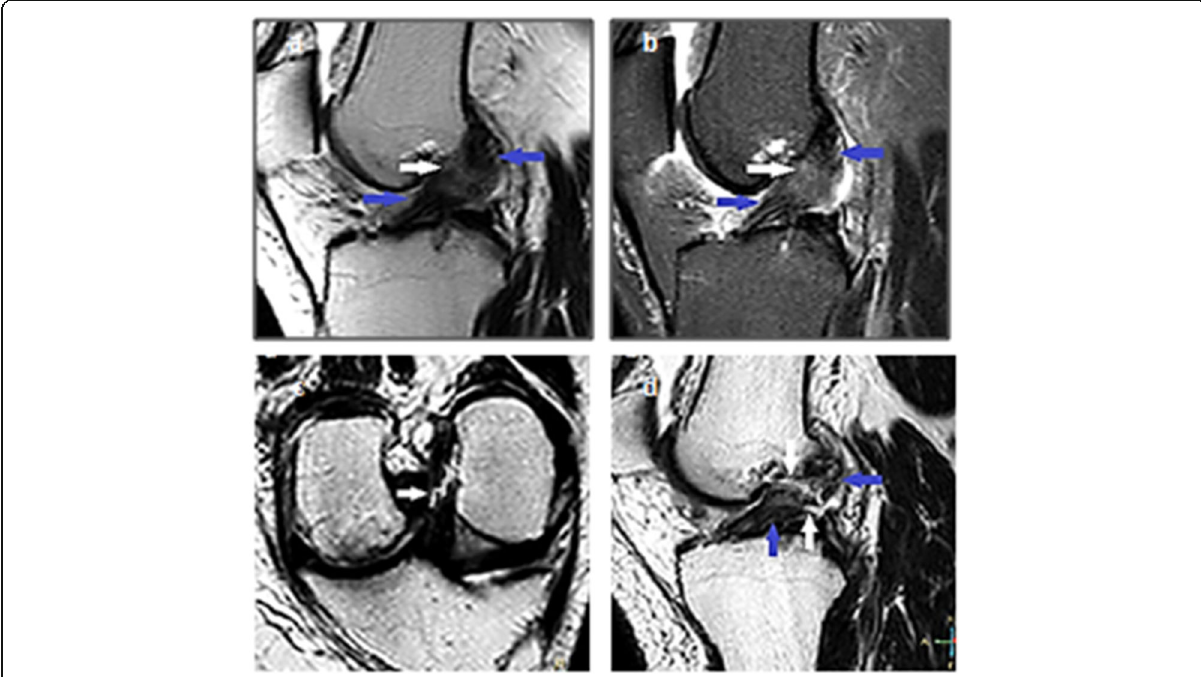
Fig. 4 A female patient, 45 years old, complaining of knee trauma after a road traffic accident. a Sagittal T2 and b sagittal T2 fat suppression showing intrasubstance areas of increased signal intensity with ACL fibril discontinuity of ACL at the mid-substance in all pulse sequences (white arrows), compatible with high-grade partial tear of the ACL. Residual stumps on femoral and tibial sides (blue arrows) are thickened and increased in MR signal intensity. c Oblique coronal T2 and d oblique sagittal MRI images showing complete fiber discontinuity across the mid- substance of ACL with intrasubstance areas of high-signal intensity (white arrows) compatible with complete tear of the ACL. Residual stumps on femoral and tibial sides (blue arrows) are lax, thickened, and increased in signal